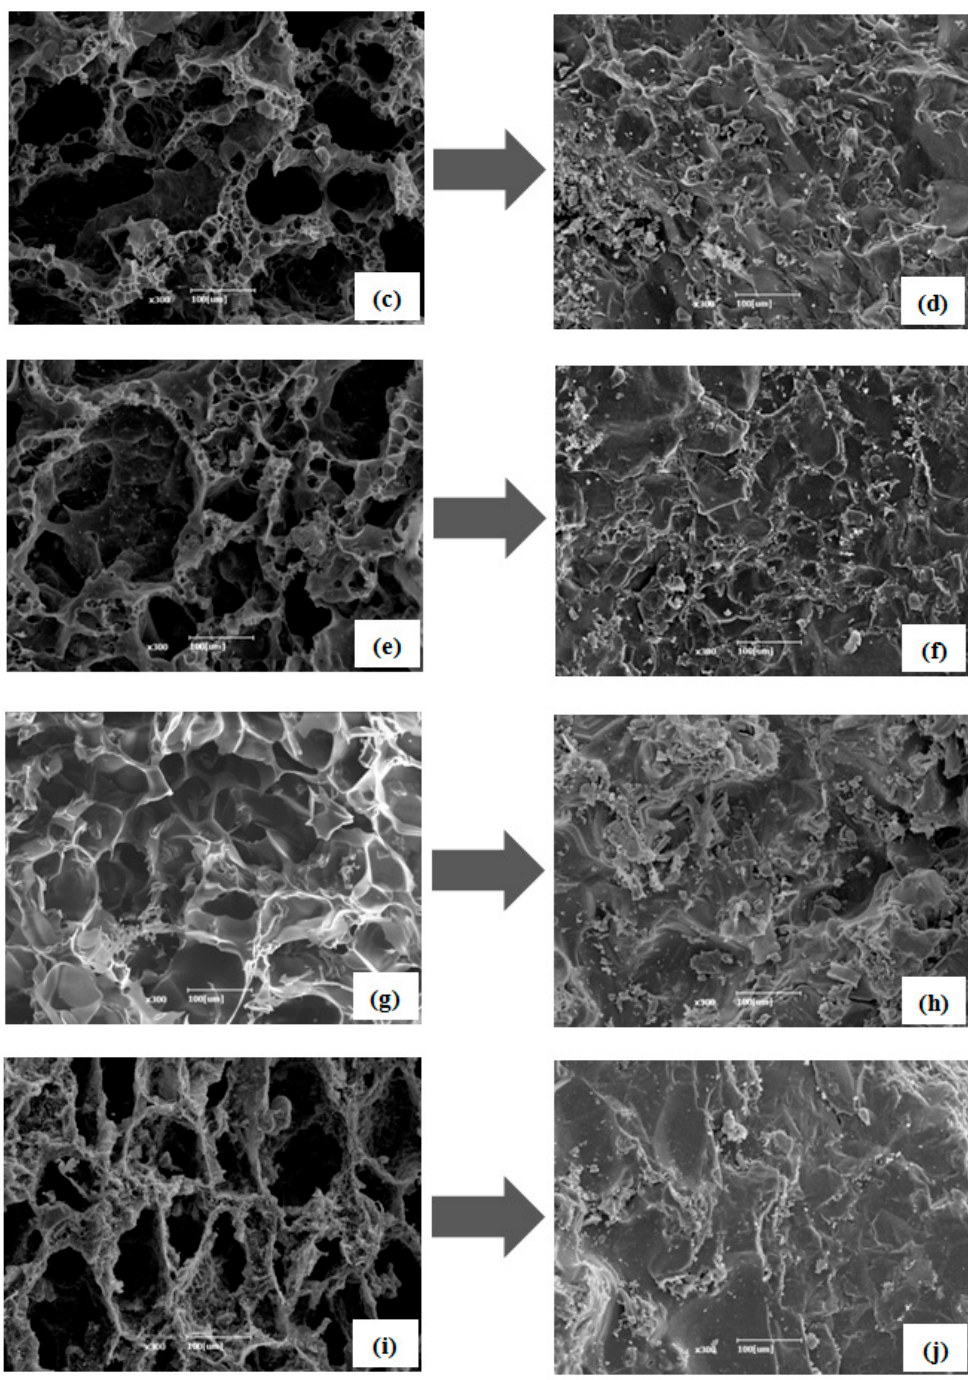
Figure 6. SEM images of ( a ) CF; ( c ) CF-Ag; ( e ) CF-Al; ( g ) CF-CNT; and ( i ) CF-G, as well as the SEM images for the corresponding carbon foams impregnated with erythritol ( b , d , f , h , j , respectively).